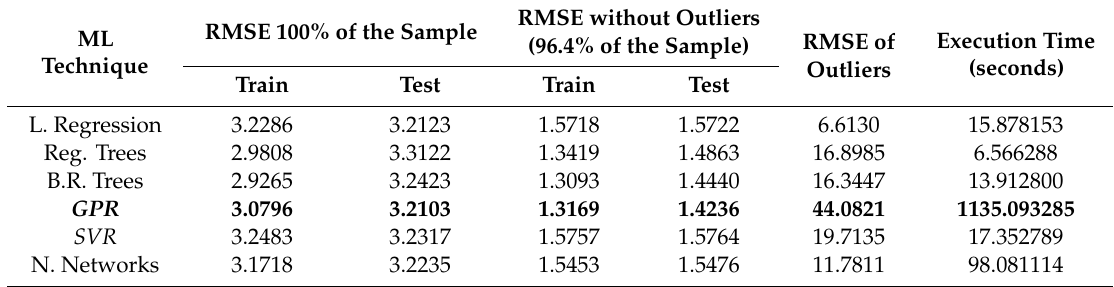
Table 16. SSDE-CTDI VOL results for Abdomen & Pelvis protocol.